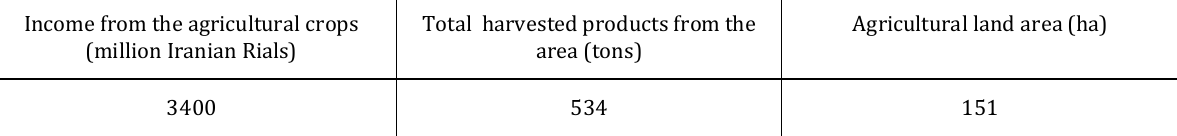
Table 3. The total income of agricultural land in the protected